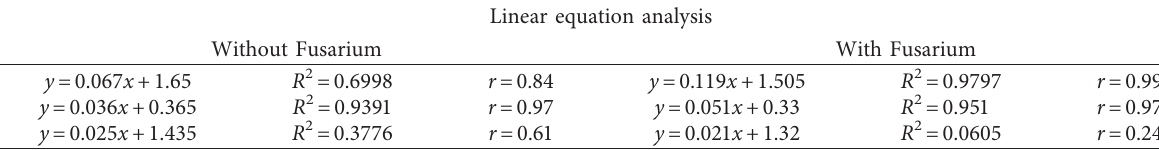
Table 3: Regression analysis of Fusarium treatment on vanilla plants.